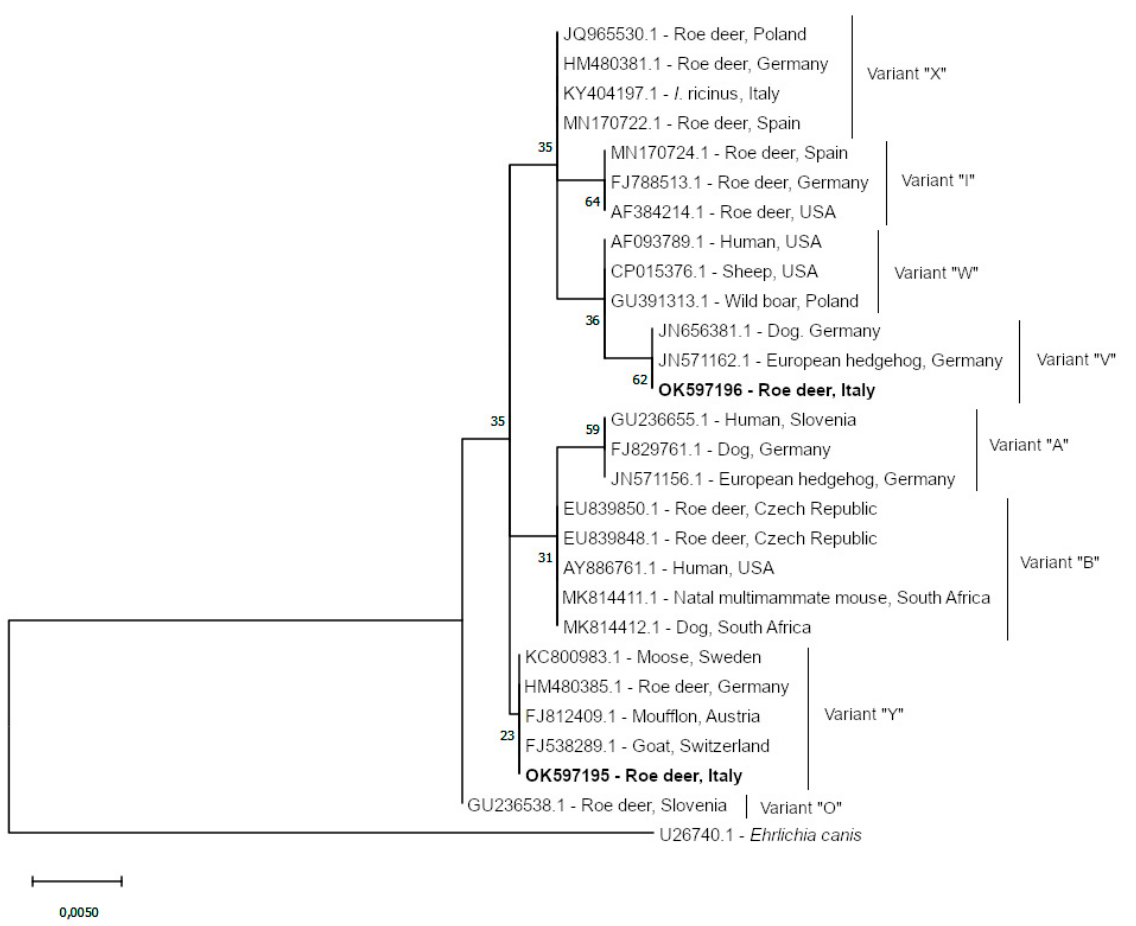
Figure 1. Maximum likelihood phylogenomic tree of the partial 16S rDNA gene of A. phagocytophilum obtained with MEGA X [33] and Kimura 2-parameter [32] model showing clustering variants (100 replicates; bootstrap values are indicated at the nodes). Ehrlichia canis 16S rDNA sequence (U26740) was used as outgroup. The tree is drawn to scale, with branch lengths measured in the number of substitutions per site. Isolates identified in this study are indicated in bold font.